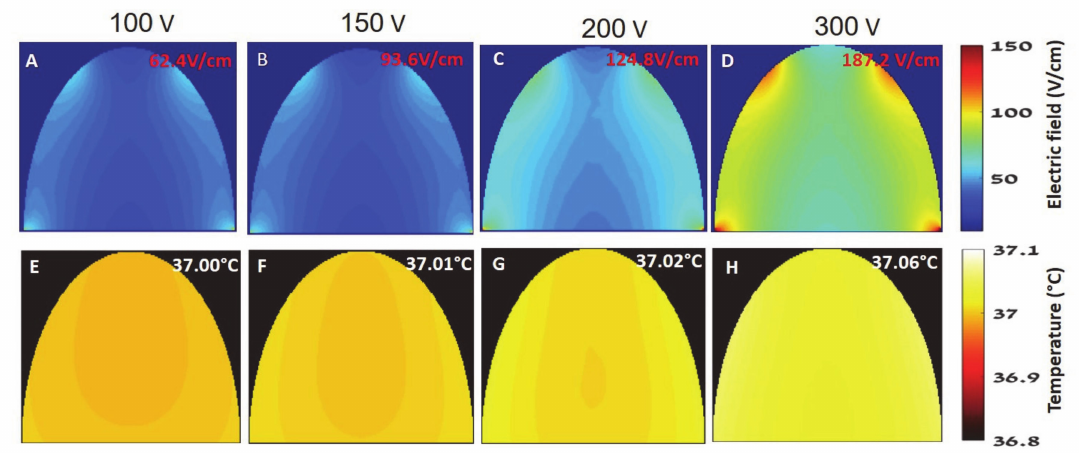
Figure 8. Electric field and temperature distributions after 100 pulses as calculated from the finite elements simulation ( A – D ). Electric field distribution ( E – H ). Temperature distribution. ( A ) + ( E ) 100 V. ( B ) + ( F ) 150 V. ( C ) + ( G ) 200 V. ( D ) + ( H ) 300